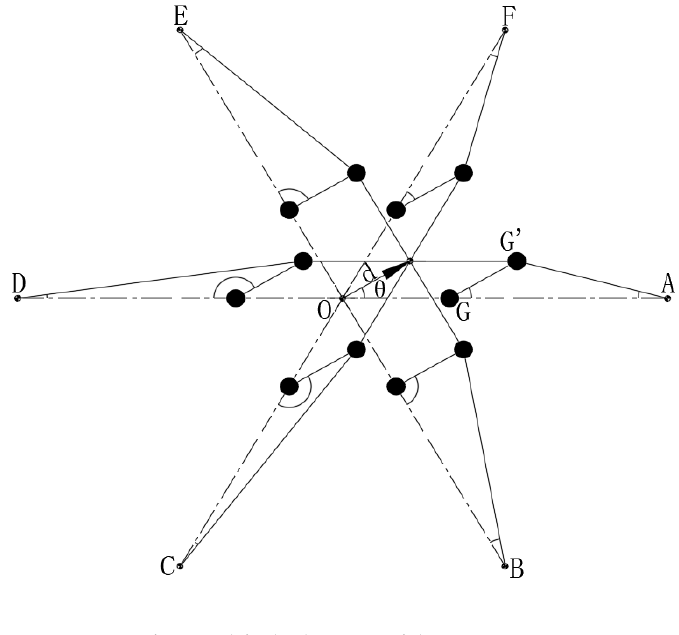
( b ) Simplified schematic of the movement Figure 3. Kinematic response of the VEAM to cable displacement. Figure 3. Kinematic response of the VEAM to cable